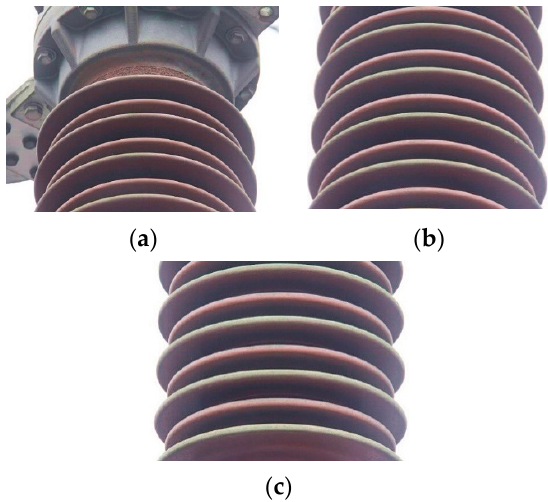
Figure 3. The different height positions of the 110 kV circuit breaker in YA 110 kV BQS. ( a ) High voltage side. ( b ) Middle. ( c ) Low voltage side.